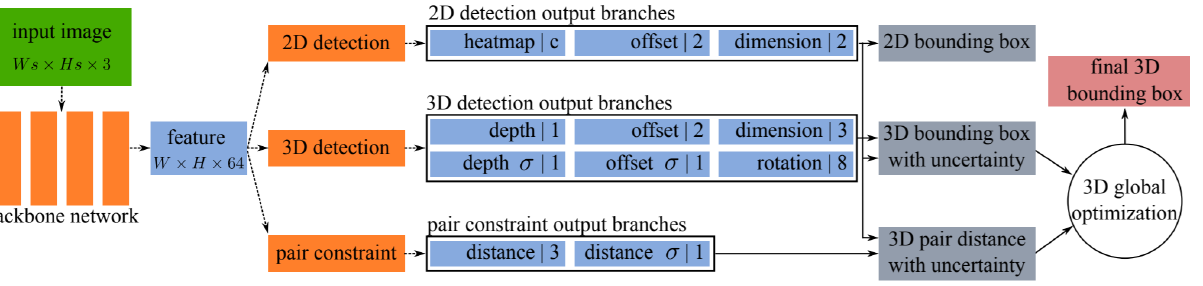
Figure 5. The architecture [55] overview with eleven prediction branches divided into 2DOR, 3DOR, and pair